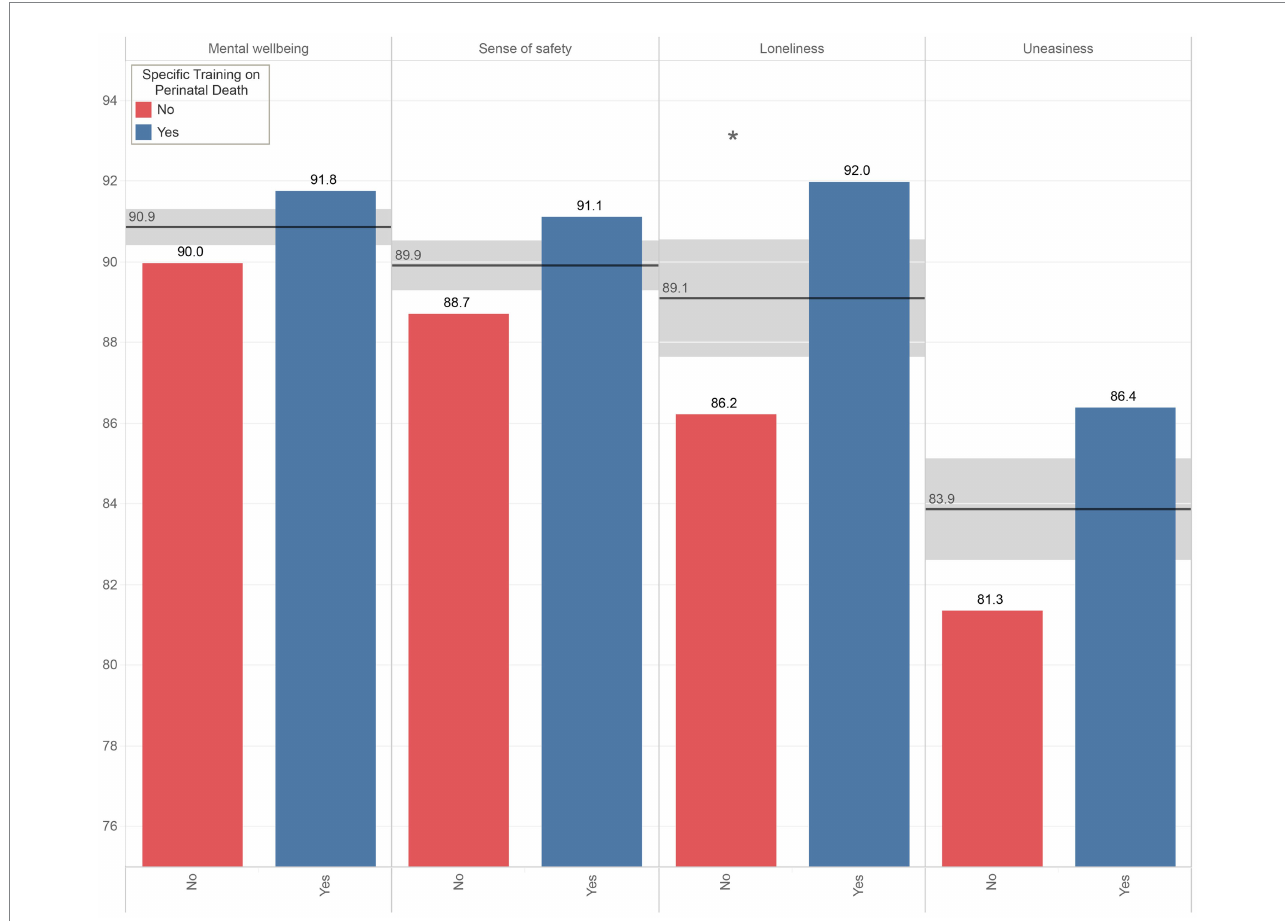
FIGURE 4 Percentages of HCPs who considered the relationship between physician and patient to be important when a neonatal death occurred in the areas of patients’ mental wellbeing, sense of safety, feeling of loneliness and feeling of